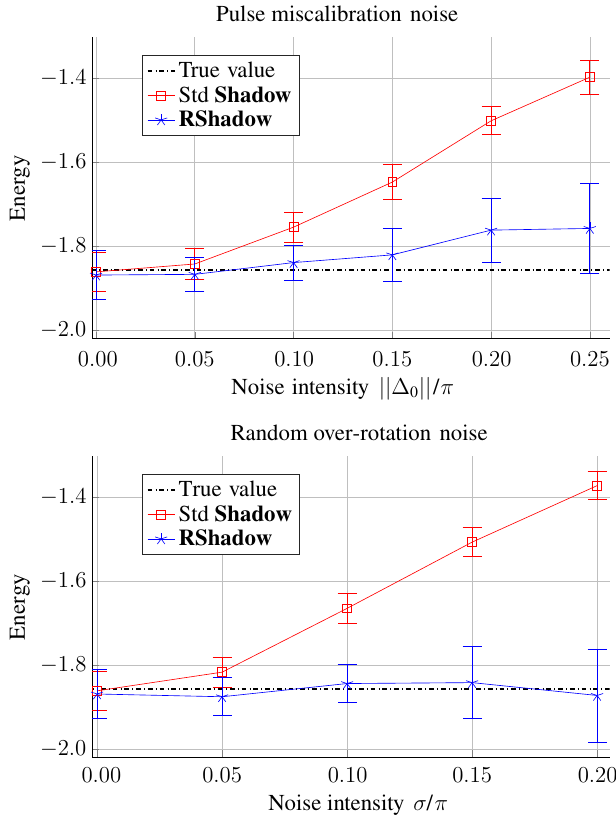
FIG. 7. Upper: ground-state energy estimation of H 2 with pulse miscalibration noise. We choose the uncalibrated Hamiltonian (cid:11) 0 : = (cid:13) (cid:11) 0 (cid:13) ∗ ( aX + bY + cZ ) , where [ a , b , c ] = [ − 0.5500, 0.2878, 0.7840] is a fixed randomly generated unit vector. See Appendix E 2 for evidence that this choice of vector is not special. Lower: ground-state energy estimation of H 2 with random over-rotation noise. Here σ is the standard deviation of the random over-rotation angle δ